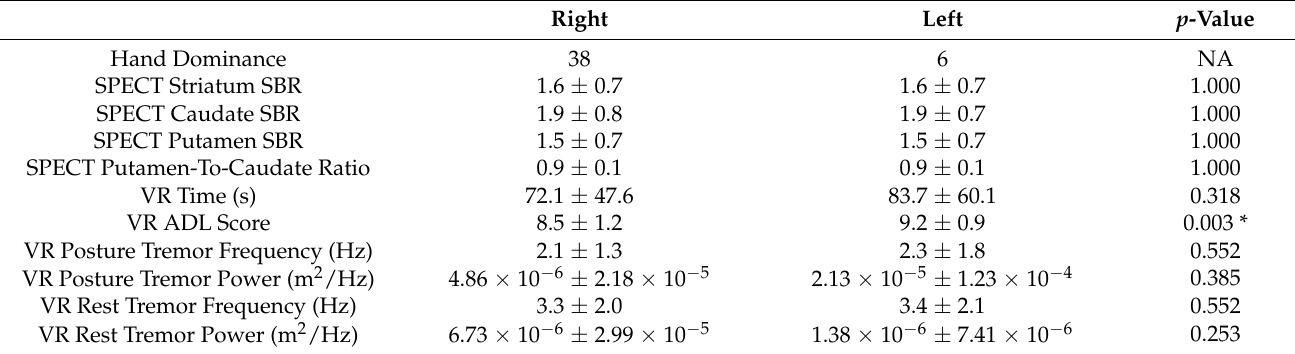
Table 2. Hand dominance, virtual reality (VR), and [ 123 I]FP-CIT SPECT results based on laterality. Right